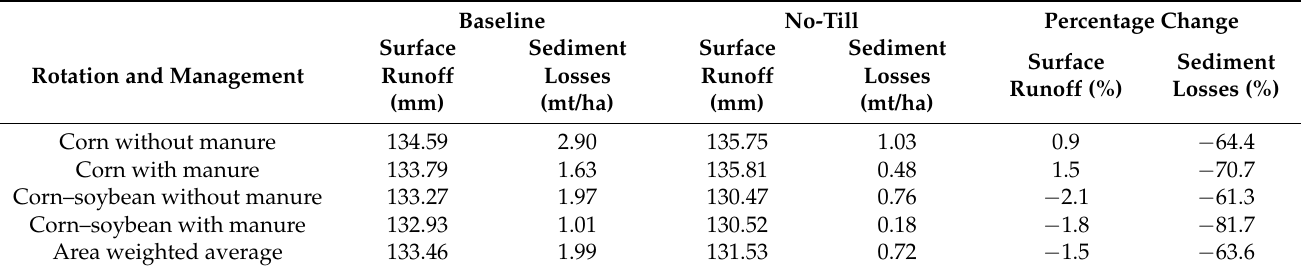
Table 5. Conservation tillage impacts on annual surface runoff and sediment losses. Baseline